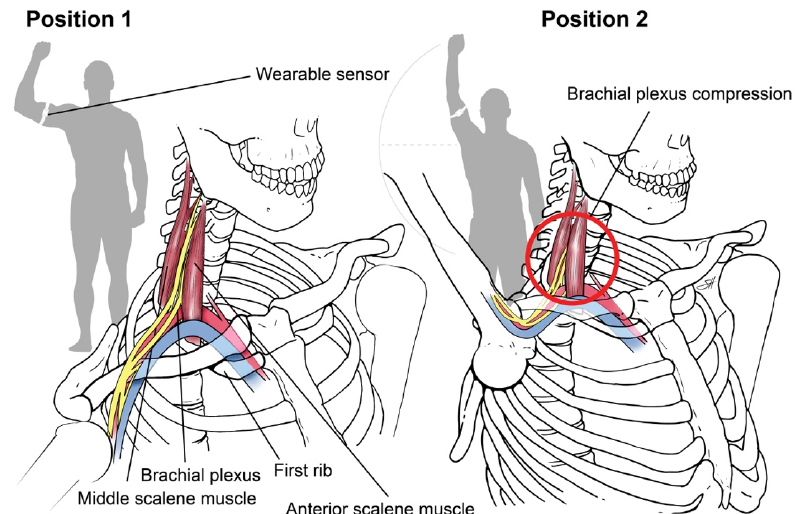
Figure 1. Press Test . We designed a 20-s repetitive hand-over-head exercise that narrows the scalene triangle and exacerbates the symptoms of nTOS by anatomically narrowing the scalene triangle with arm elevation. Using an inertial measurement unit, digital biomarkers of nTOS were identified.